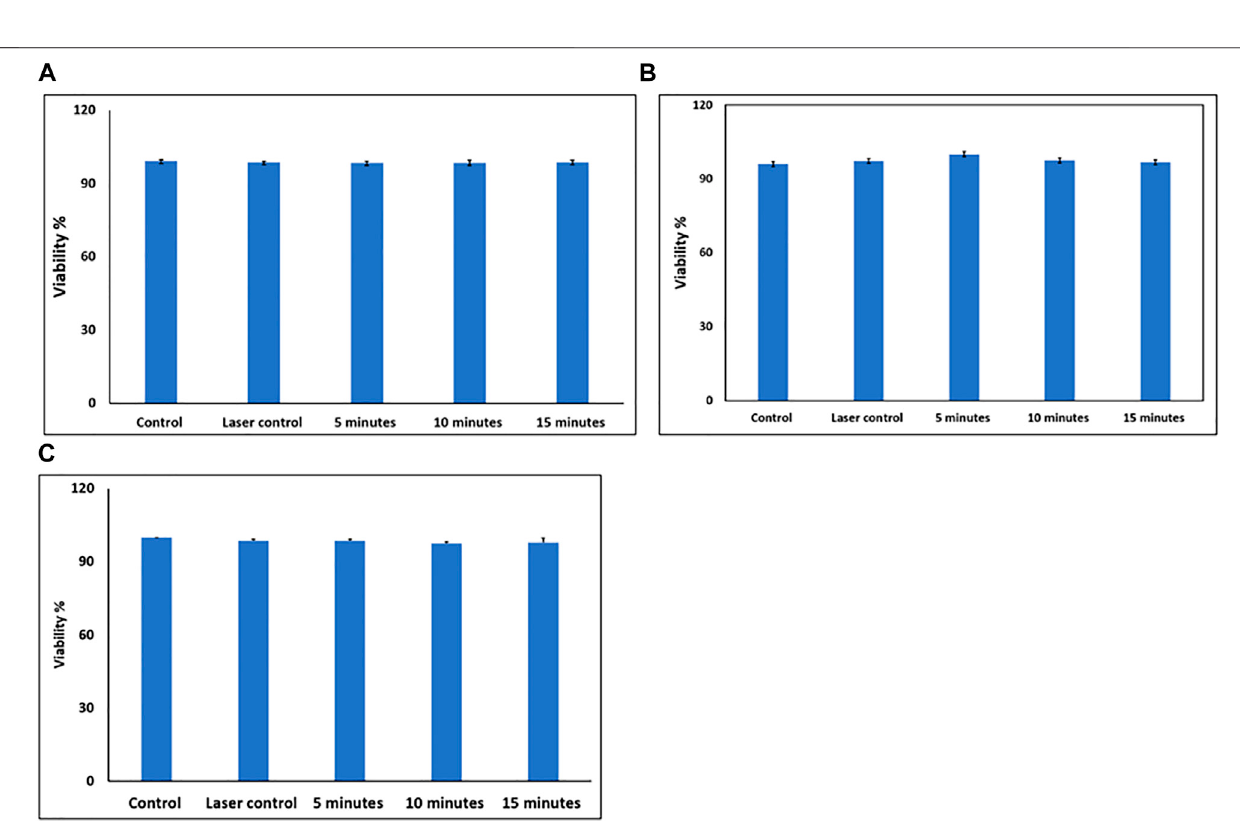
treated under different conditions. For the static and dynamic conditions, cells were treated with 100 or 200 µg/ml MXene and were exposed for four or 8 h. Material uptake was considered to occur if the material is attached to the cell ’ s surface (association) or present inside the cell (internalization). As shown in Figure 5 ,